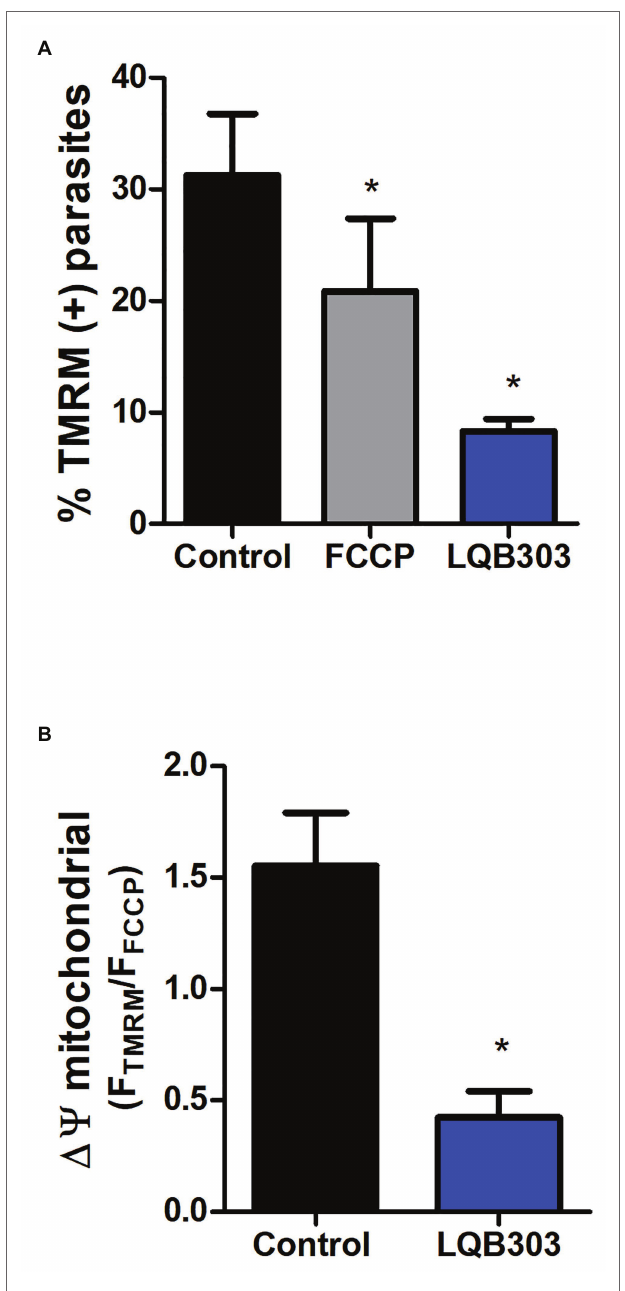
FIGURE 1 | Effect of LQB303 on extracellular amastigotes mitochondrial membrane potential ( ∆Ψ m). Extracellular amastigotes of T. cruzi were pre-incubated with LQB303 for 24 h. (A) Parasites were incubated with 50 nM TMRM for 30 min, following with the addition of FCCP 5 μ M for 5 min to measure ∆Ψ m by flow cytometry. Then the percentage of TMRM-labeled parasites was plotted in the presence or absence of 3 μ M LQB303 and 5 μ M FCCP. (B) The F TMRM /F FCCP ratio was used to estimate the ΔΨ m, where F TMRM is the mean fluorescence intensity of TMRM (F max ) and F FCCP is the mean fluorescence in the presence of the uncoupler FCCP (F min ). All experiments were expressed as median ± SD of four experiments. One hundred thousand cells were quantified in each experiment, * p < 0.05 when compared to the control group by one-way ANOVA test (Tukey